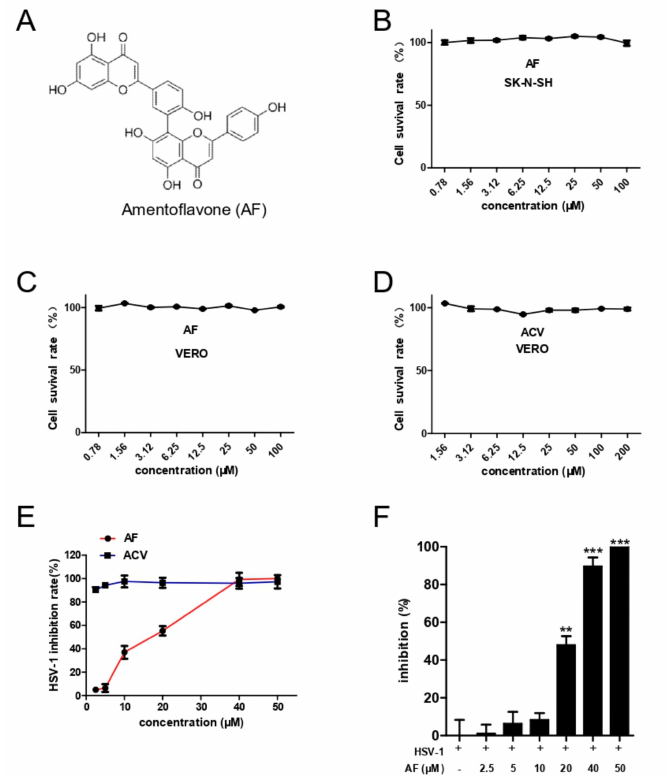
Figure 1. Toxicities and antiviral activities of amentoflavone. ( A ) Chemical structure of amentoflavone. ( B – D ) Cytotoxicities of ACV and amentoflavone. SK-N-SH and Vero cells were treated with di ff